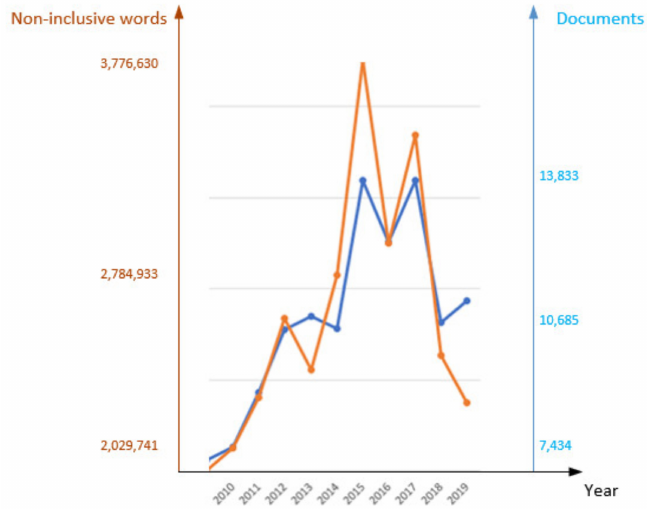
Figure 14. Comparative evolution of documents and the detected non inclusive uses of